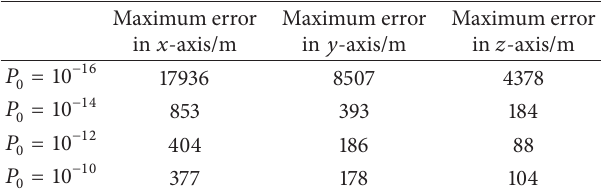
Table 4: The maximum AOD error of 𝐿 1 using SR-EKF with